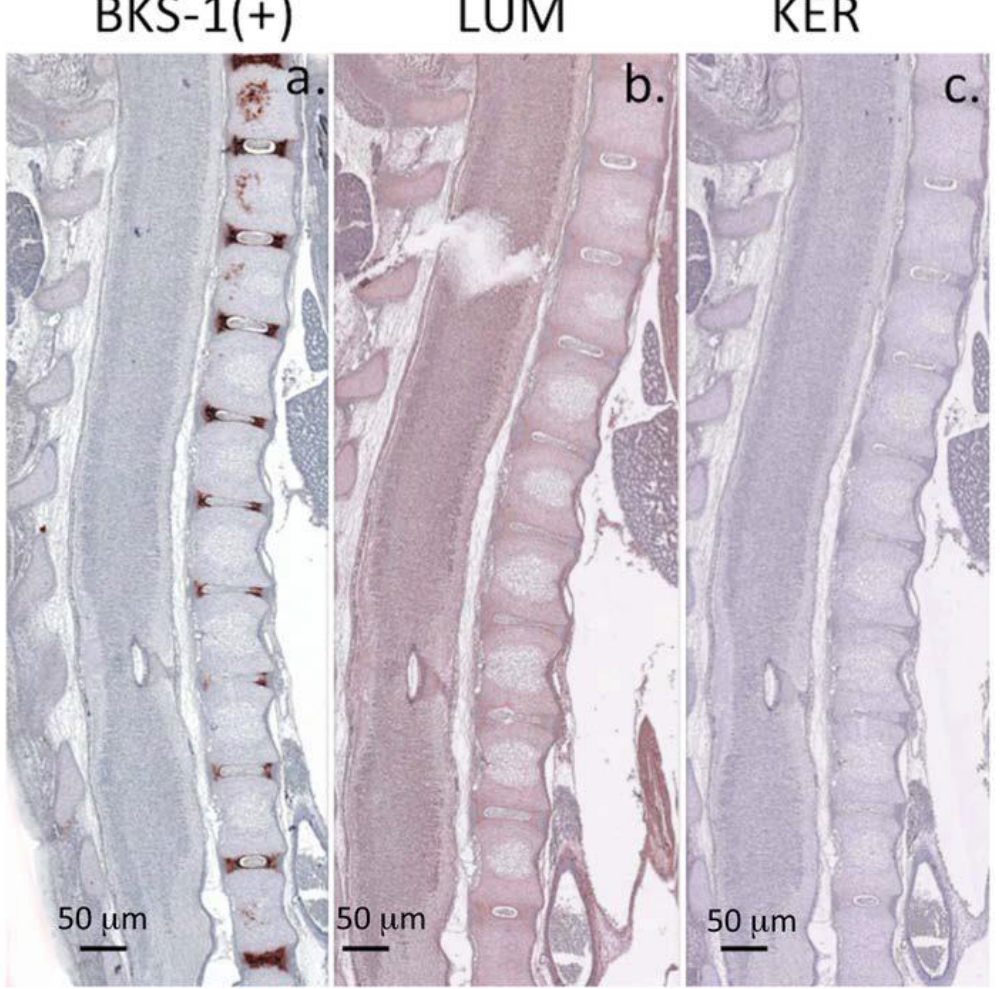
Figure 5. Macroscopic longitudinal sections depicting the immunolocalization of BKS-1( + ) KS neoepitope in chondroitinase ABC, keratanase I-digested spinal tissue sections ( a ), lumican ( b ), and Keratocan ( c ). BKS-1( + ) reactivity is evident in the pre-ossification centers in the vertebral bodies, and the cartilaginous inner annulus fibrosus of the developing intervertebral discs ( a ). BKS-1 ( + ) is also immunolocalized to the notochordal sheath surrounding notochordal remnants in the central intervertebral disc at some levels but not in the notochord itself which has been lost by this stage. Staining for BKS-1 ( + ) epitope is negative in the spinal cord at this stage of spinal development and only weak for lumican. Scale bars 100 μm. NovaRED chromogen.